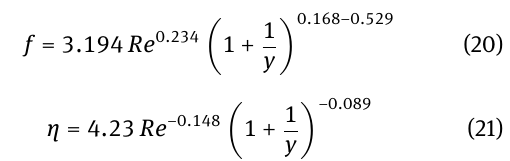
Figure 11: Comparison between predicted and experimental friction factors.